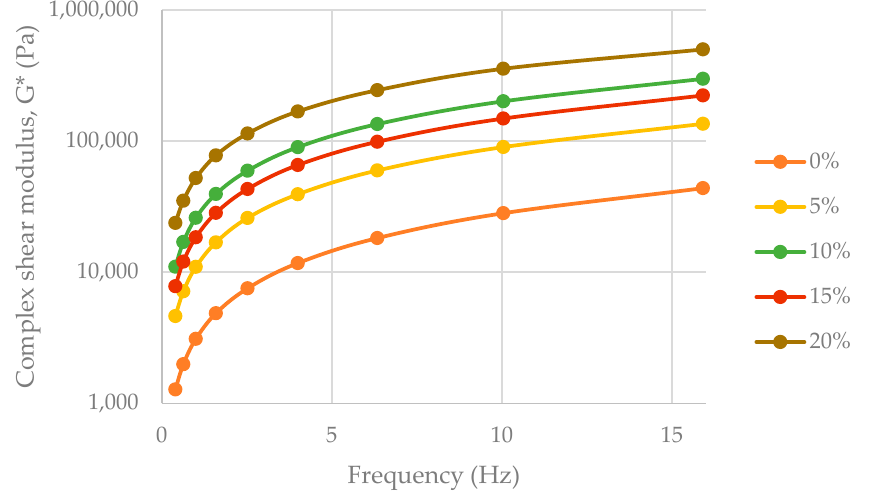
Figure 1. Representative plot of complex shear modulus (G*) versus frequency at 60 °C at varying concentrations of TLA/TBP blend with toner D additive.